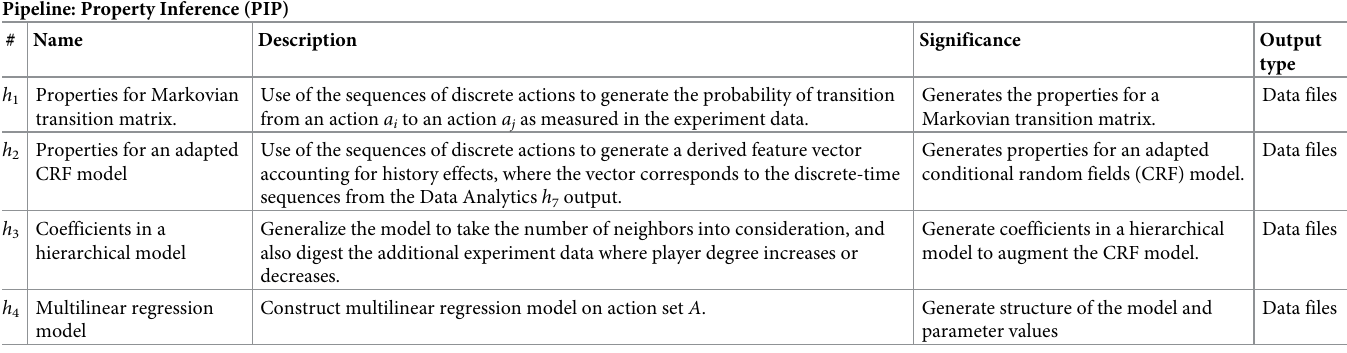
Table 11. Listing of types of functions as microservices for the (3) Property Inference Pipeline (PIP). Pipeline: Property Inference